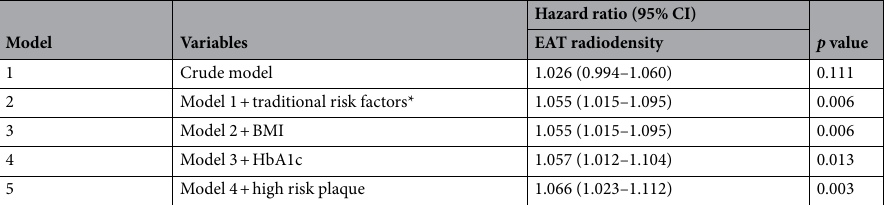
Table 2. Association between EAT radiodensity and all-cause mortality in crude and multivariable adjusted cox regression analysis. BMI body mass index, CABG coronary artery bypass graft, CAD coronary artery disease, CT computed tomography, EAT epicardial adipose tissue, hs-CRP high sensitivity C-reactive protein, LVEF left ventricular ejection fraction, PCI percutaneous coronary intervention. *Adjusted for age, sex, diabetes status, smoking status, PCI or CABG (Previous or subsequent), multi-vessel CAD on CT, statin use, duration of dialysis, serum calcium x phosphorus, serum albumin, serum hemoglobin, serum hs-CRP, and LVEF.